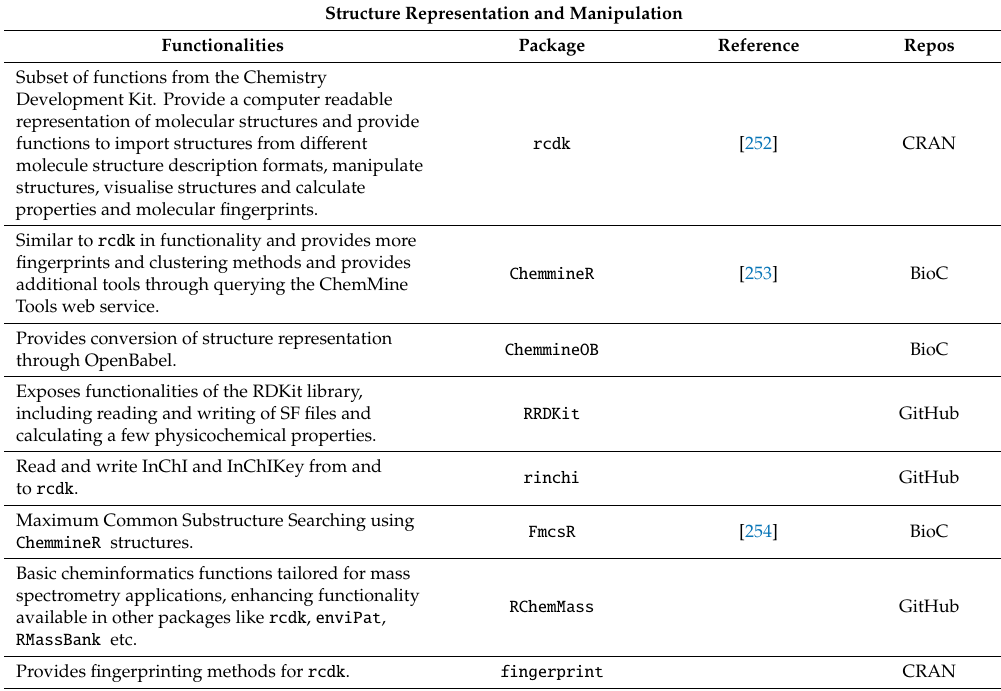
Table 7. R packages for molecule structures and chemical structure